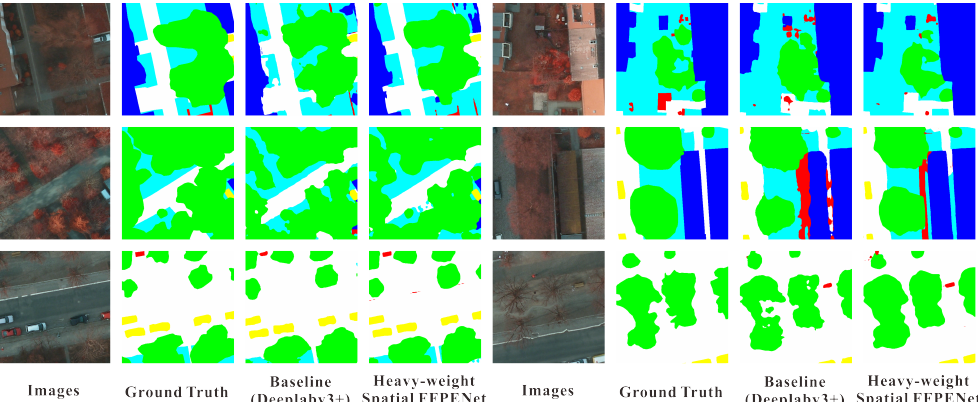
Figure 9. Qualitative comparisons between our method and the baseline (Deeplabv3+) on the Potsdam dataset with 512 × 512 patches.